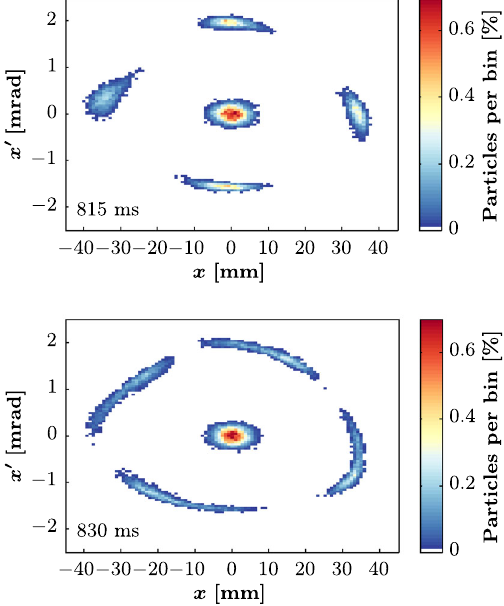
FIG. 19. Simulated horizontal phase space portraits in SS01 showing the evolution of an improved final rotation, which takes about six times longer than the one illustrated in Fig. 16. η conserved during the process and the final surface of the islands, which is shown in the bottom plot, is significantly reduced. Note that the SFP of the external island is located at x 0 ≈ − 1 mrad, which is required to properly position the beamlet in SS15 and SS16. The respective cycle times are indicated in the bottom left corners of the plots.